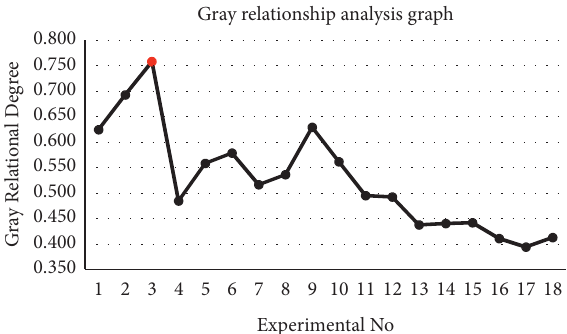
Figure 12: Gray correlation degree for lowest output